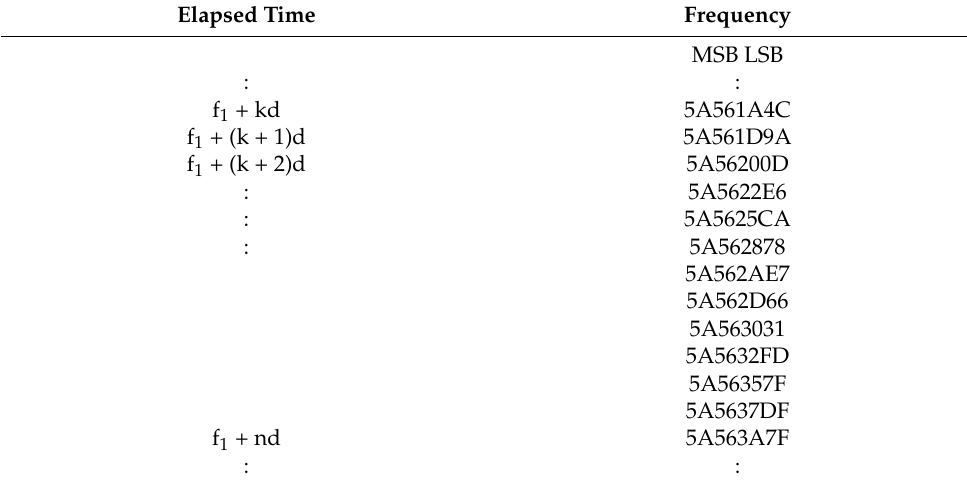
Table 2. Frequency of elapsed